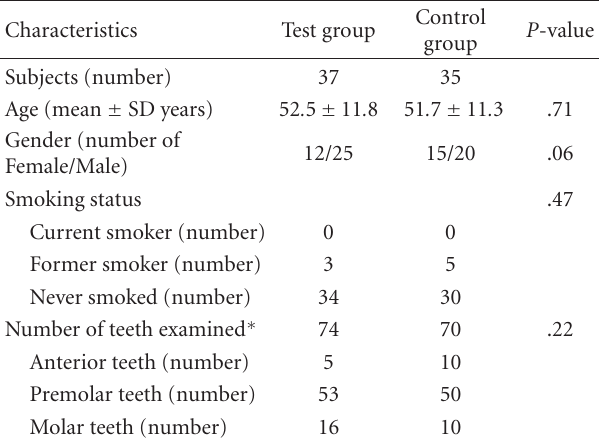
Table 1: Demographic characteristics of